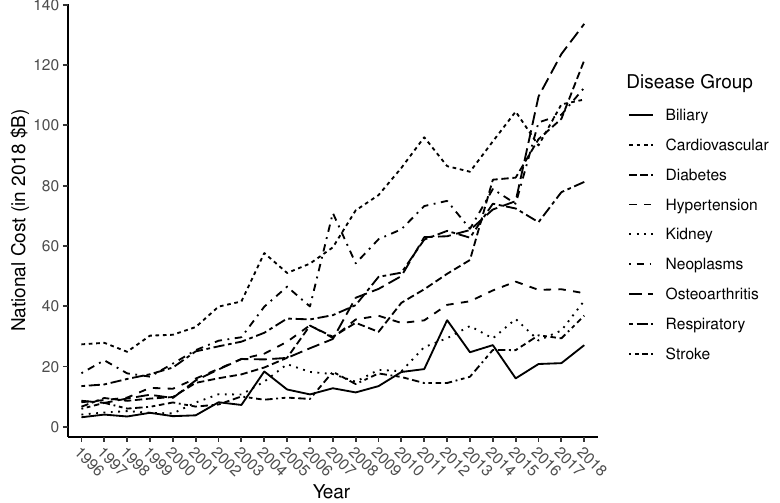
Figure 3. Direct medical cost in billions of 2018 dollars, allocated to each disease group, during the period from 1996 to 2018. Source: the Medical Expenditure Panel Survey (MEPS 2021).